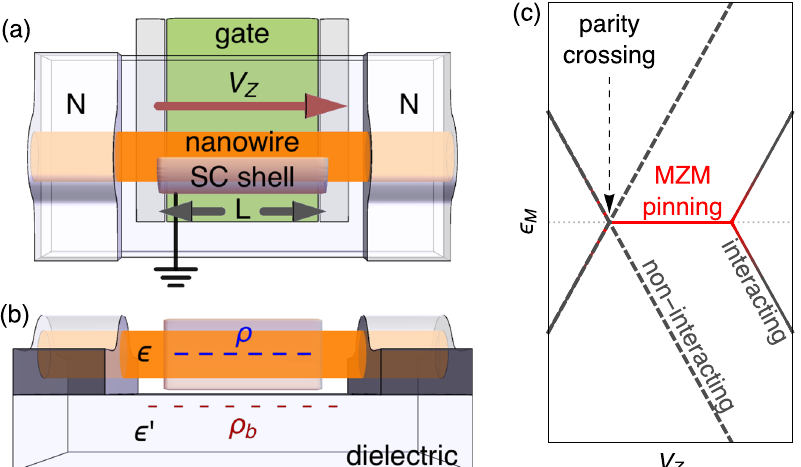
Fig. 1 a Proximitized Rashba nanowire of length L with gate-tunable Fermi energy μ and under a parallel Zeeman fi eld V Z . b Bound charges ρ b arise in the dielectric surroundings, which interact with free charges ρ in the nanowire. c Sketch of the interaction-induced pinning, discussed in this work, of Majoranas at zero energy around parity crossings. This pinning provides a natural explanation to hitherto unresolved experimental features in Majorana wires (see, e. g., Fig. 3c in ref.